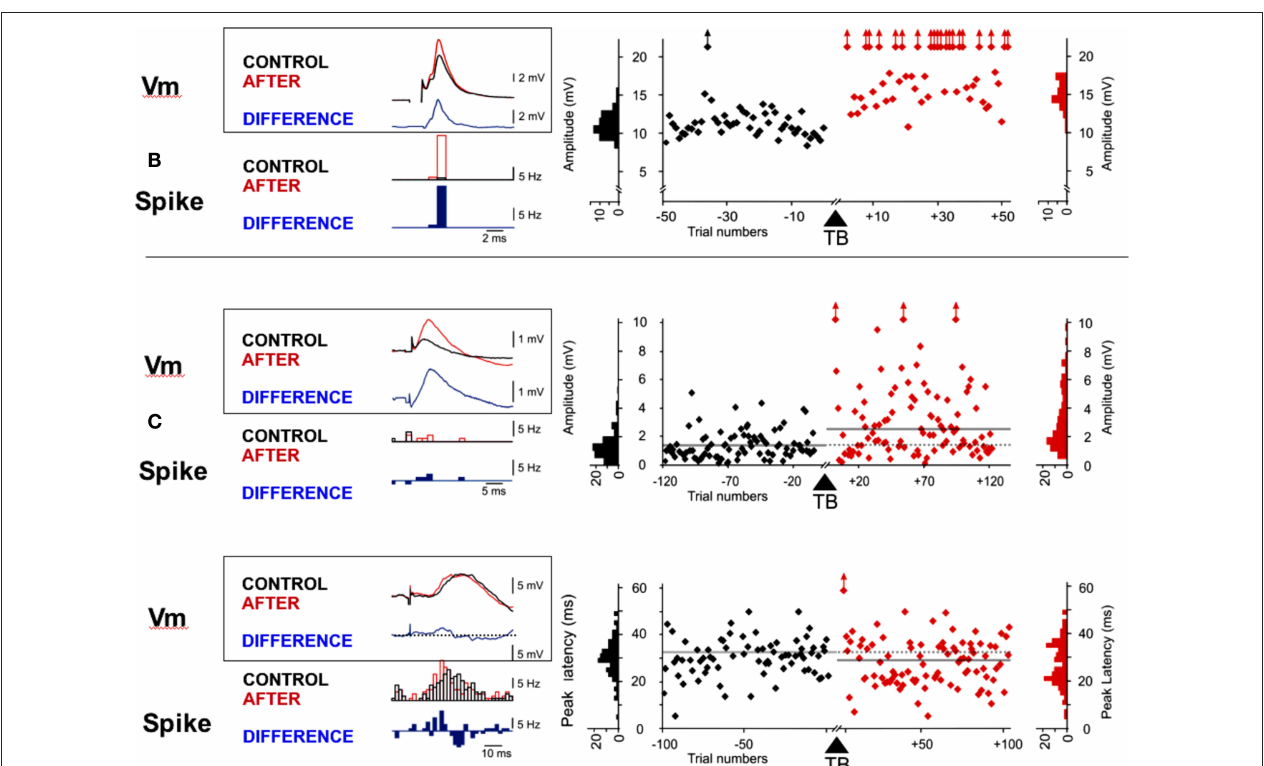
measured on individual PSPs during the pre- and post-TBS periods. Distributions of the measured values are displayed on each side of the plots. (A) Potentiation of the peak amplitude of a monosynaptic response from 11.1 mV ( σ = 1.5 mV) to 15 mV ( σ = 1.9 mV), p < 0.001. (B) Potentiation of a composite polysynaptic response, where the peak amplitude increased from 1.4 to 2.7 mV ( p < 0.001). (C) Latency shortening ( p < 0.05) of the peak response from 30.3 to 27.8 ms. Note the intermittent occurrence of shorter peak latencies (18–20 ms) after